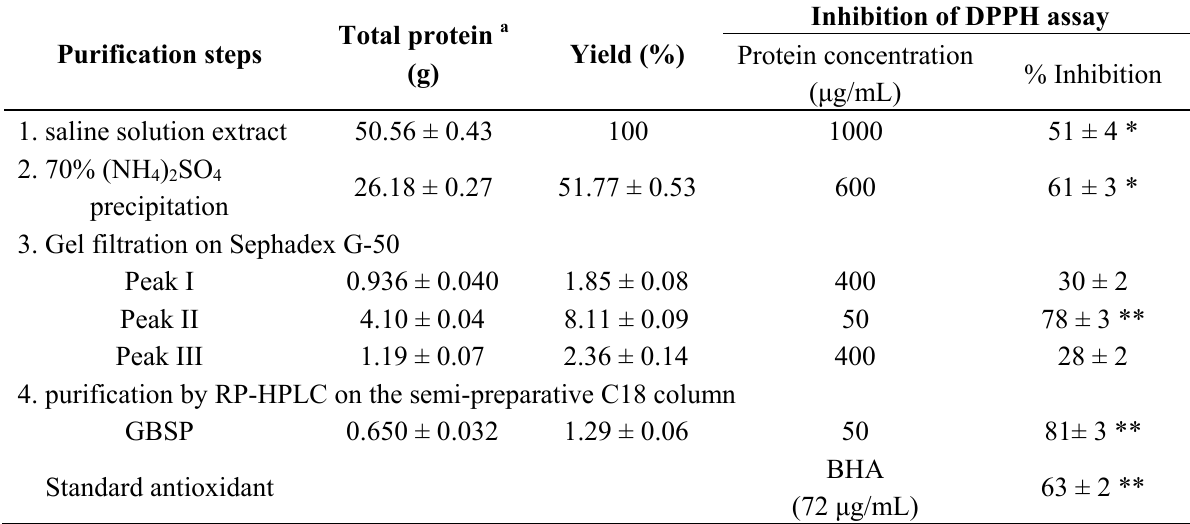
Table 1. Summary of purification antioxidant protein from Ginkgo biloba